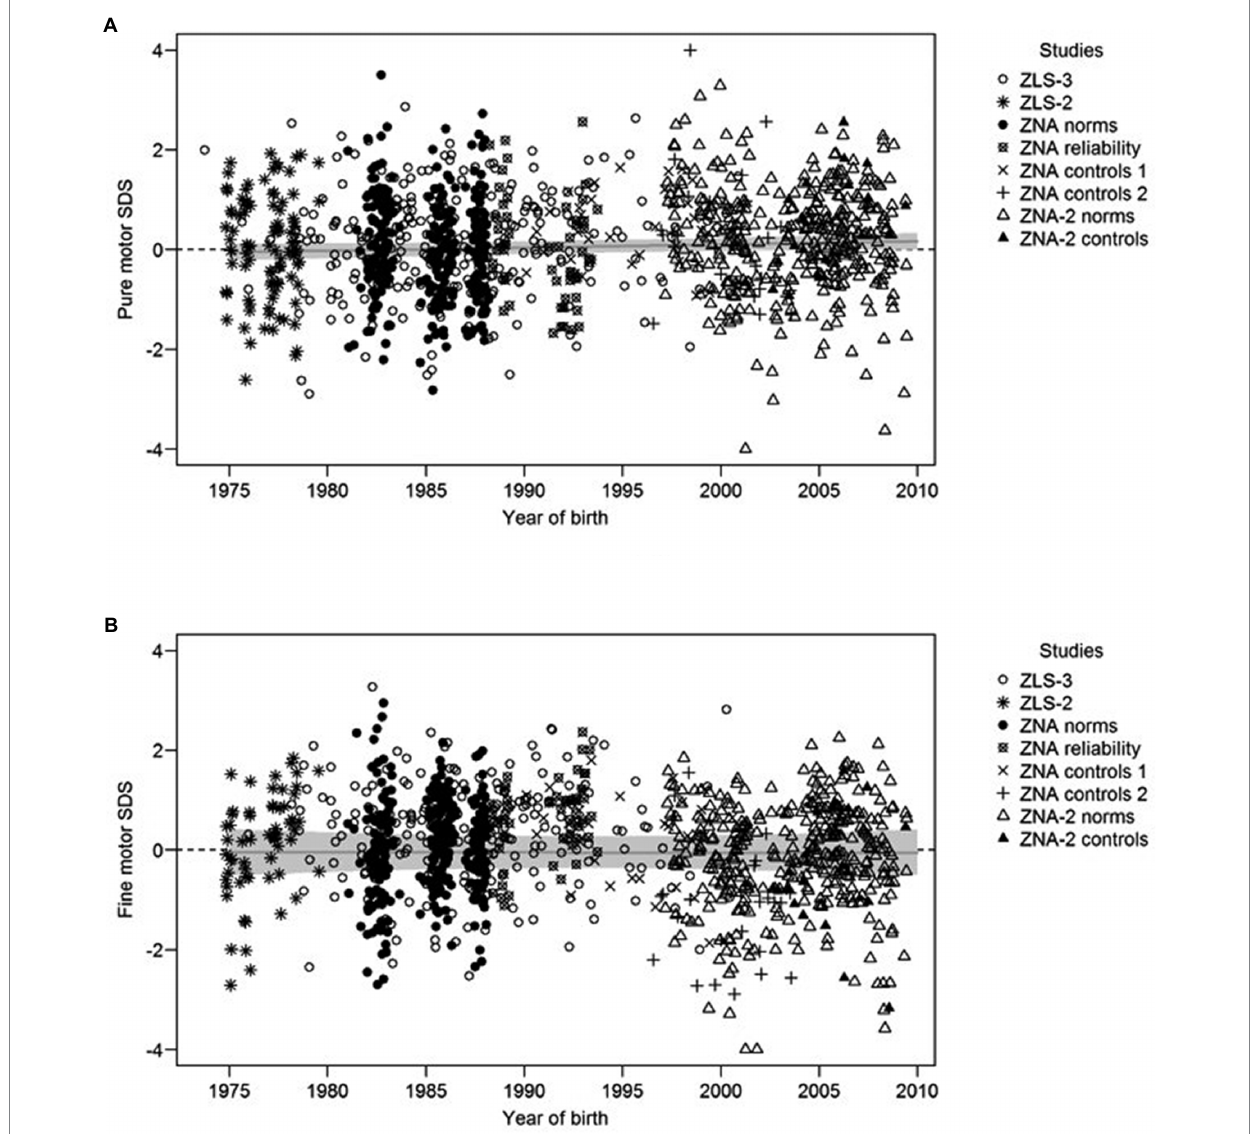
FIGURE 2 SDS of the PM (A) and FM (B) components as a function of the year of birth and the study. The regression lines refer to the predicted SDS for males in the mid age group (10–12 years) after controlling for systematic differences between studies using random intercepts. The secular trend corresponds to the slope of the regression lines. The grey area around regression lines represents a 95% CI estimated using 2000 parametric